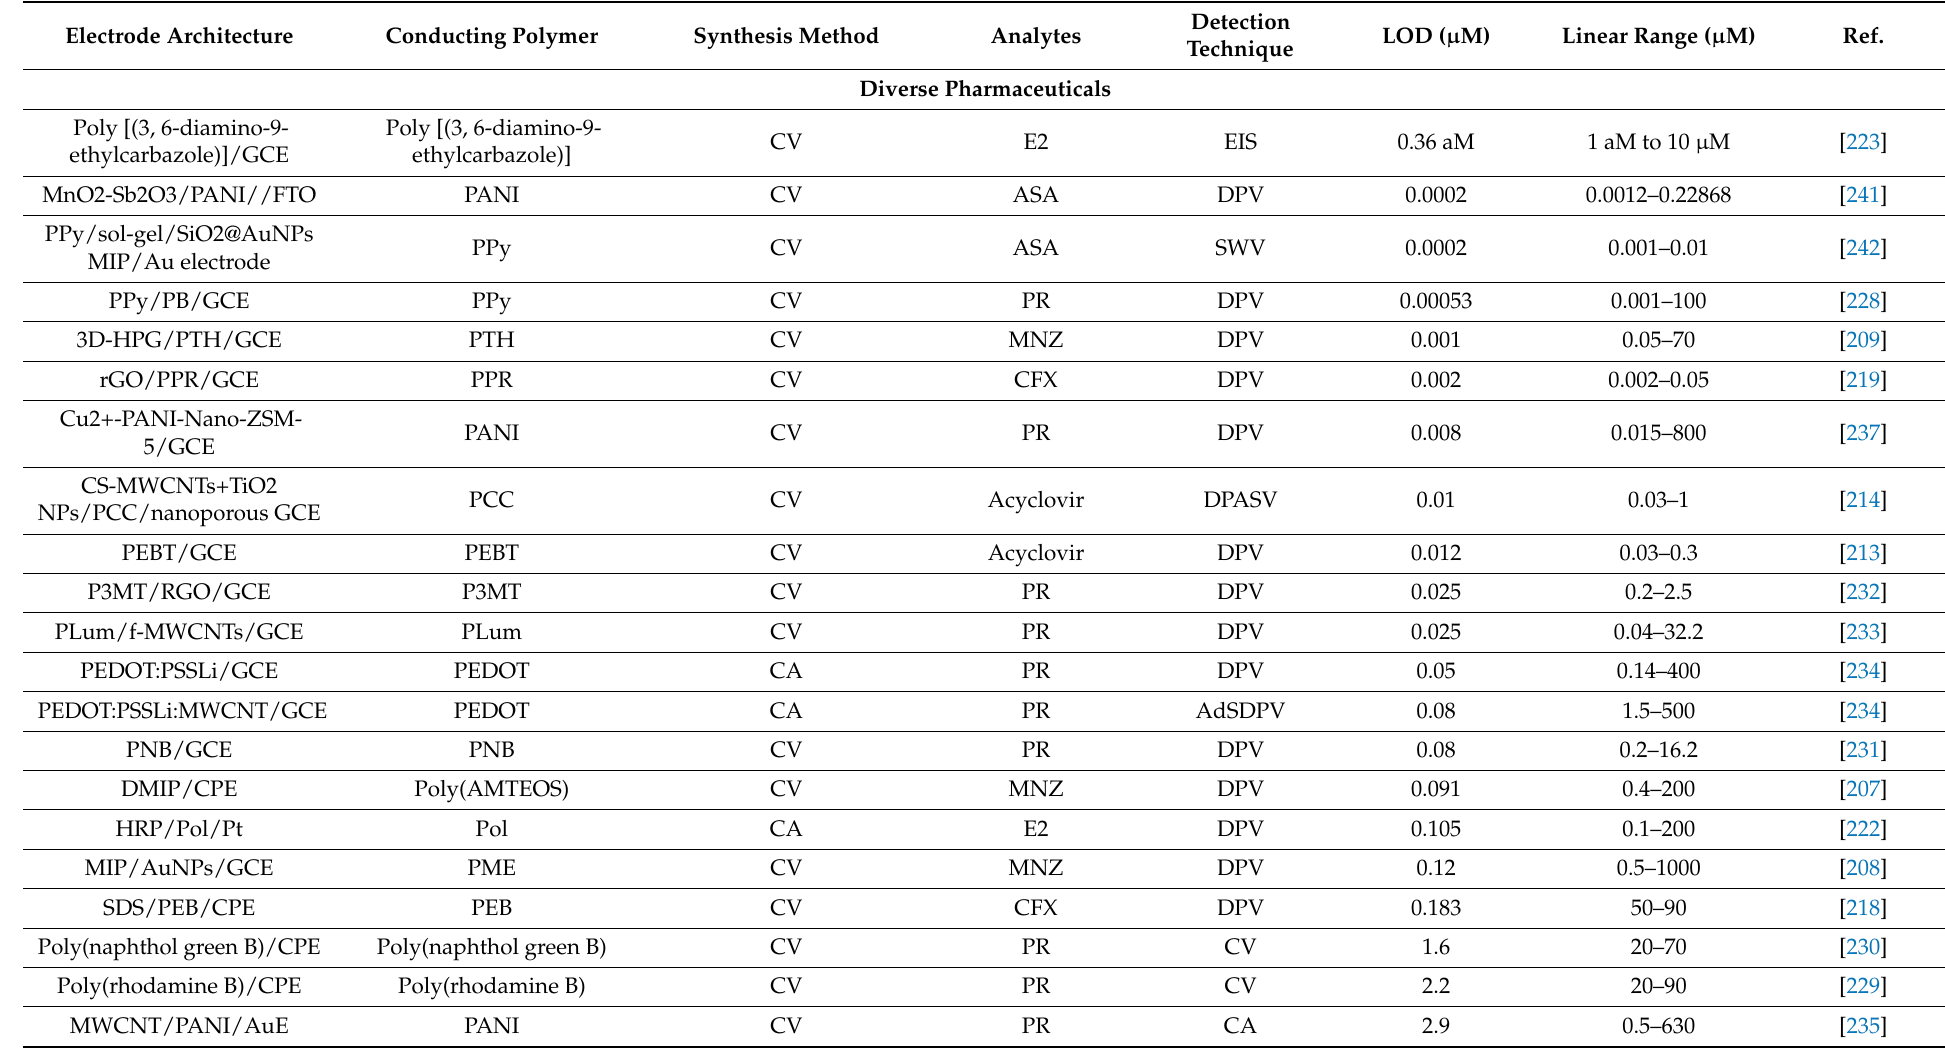
Table 2. Summary of the performance analysis of different electrochemical sensors based on conducting polymers for the detection of various water emergent